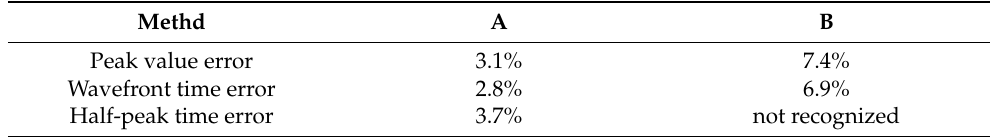
Table 4. Comparison of trend item removal methods.